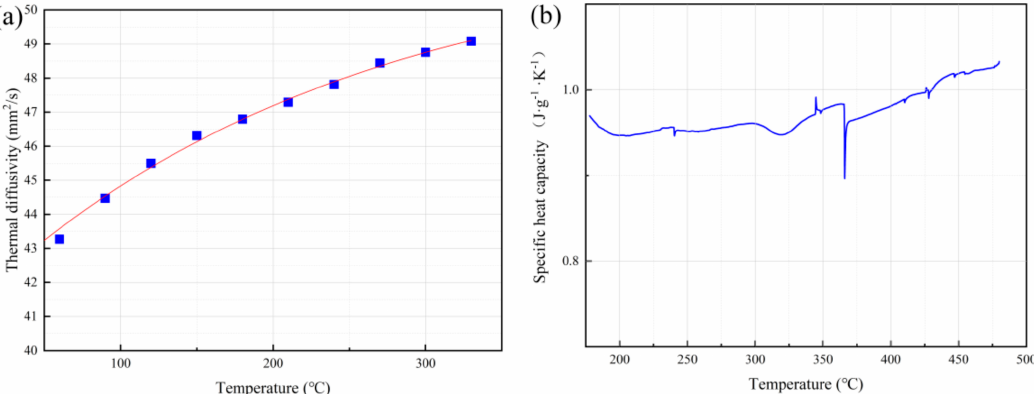
Figure 3. ( a ) Thermal diffusivity and ( b ) specific heat capacity of Al-Mg alloy deposited